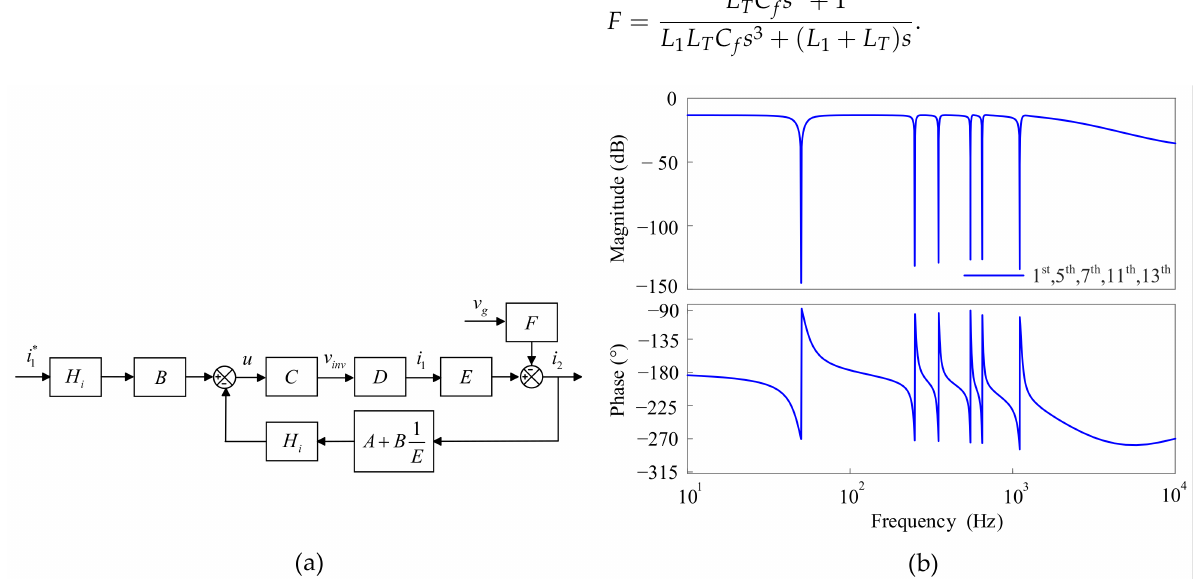
Figure 6. Analysis of the effects of the grid voltage: ( a ) Control block diagram; ( b ) Bode plot of the closed-loop transfer function G vcl ( s ) when L g =